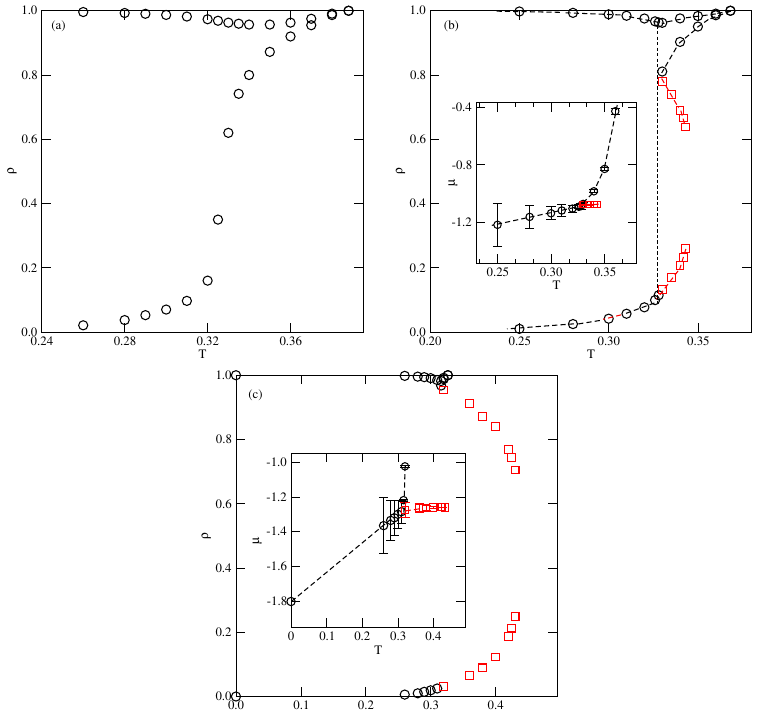
Figure 4. The T − ρ projections of bulk phase diagrams for the systems with u ∗ = − 0.05 ( a ), − 0.1 ( b ) and − 0.2 ( c ). The circles represent the phase boundaries between the disordered and ordered structures, while the squares mark the gas–liquid phase boundaries. The insets to ( b , c ) give the T − µ projections of phase